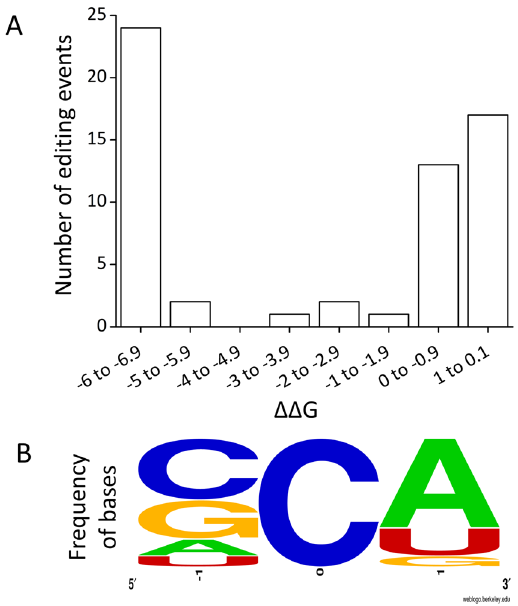
Figure 4. A-to-I edited miRNAs show predicted increased stability than their unedited forms. ( A ) The minimum free energy (MFE) for edited (“G” containing) and unedited (“A” containing) pre-miRNA was obtained using RNA fold. ΔΔ G was calculated by subtracting MFE of unedited miRNA from edited miRNA. Negative value of ΔΔ G means more stable edited forms. 55% (33/60) sites showed an increase in stability ( ΔΔ G < zero), 24 out of the 33 sites showed a value less than − 6 Kcal/mole. ( B ) The motif for sequence preference in the pre-miRNA fold-back structure is analysed. For all the miRNAs that gained stability upon editing ( ΔΔ G < − 6.0 Kcal/mole) the edited adenosines were found to have mis-paired cytosines on the pre- miRNA hairpin